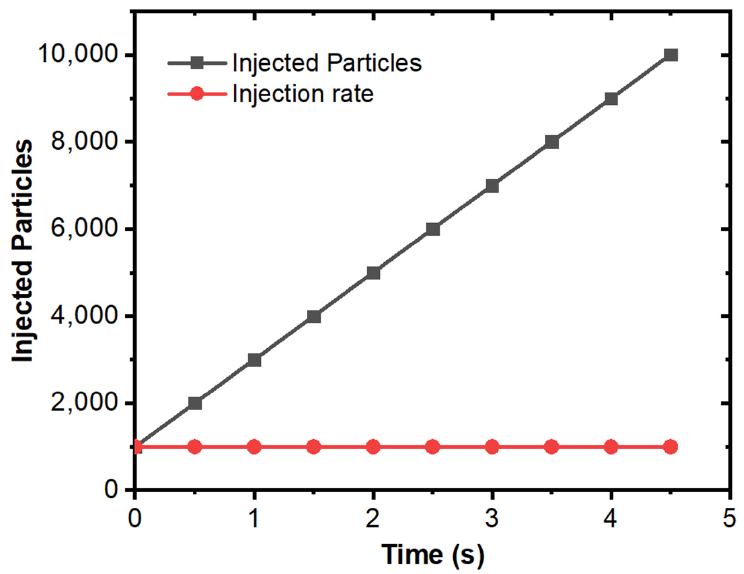
Figure 13. Injection rate and total particles in the mold using DPM modeling.